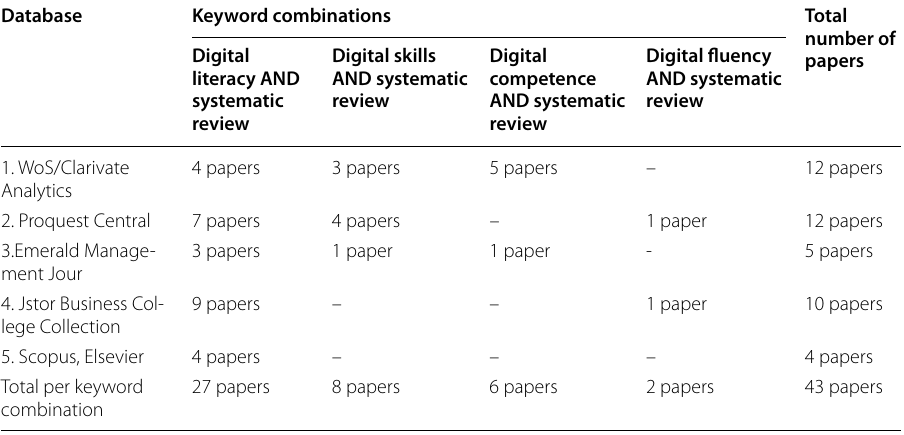
Table 1 Number of papers identified sequentially after applying all inclusion and exclusion criteria